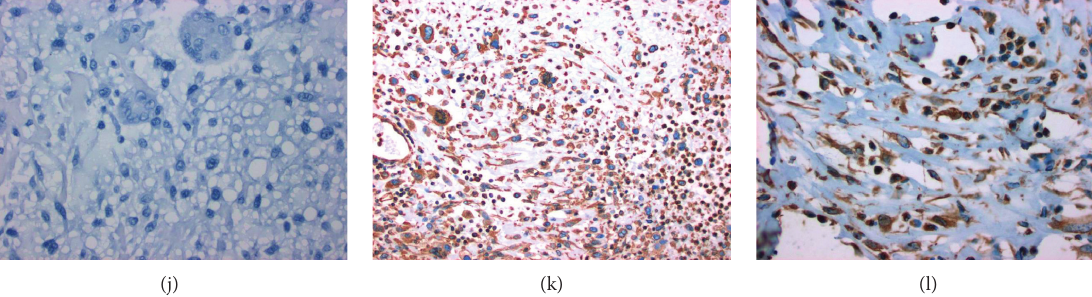
Figure 3: Microscopic pathology of the tumor. (a–d) Microscopic images of a fungating polyp. (a) Sheets of squamous cells displayed malignant features including large cell size and keratinization, providing evidence of squamous-cell carcinoma at 10x magnification. (b) The tumor arose in the background of a fundic gland polyp at 4x magnification. (c) Regions of the tumor and the entire lymph node metastasis displayed osteosarcomatous differentiation, evidenced by osteoid (pink) and associated atypical enlarged spindled cells at 20x magnification. (d) Evidence of both adenocarcinoma (left) and osteosarcoma (right) in the same fungating polyp tissue at 10x magnification. (e, f) AE1/AE3 staining. (e) Sarcomatous tissue of the tumor stained negative for AE1/AE3 seen at 20x magnification. (f) Adenocarcinoma component of the main tumor stained positive for AE1/AE3 imaged at 10x magnification. (g) Osteosarcoma component of the main tumor stained negative for AE1/AE3 at 10x magnification. (h) The squamous-cell carcinoma component was positive for P40 seen at 10x magnification. (i) The undifferentiated pleomorphic sarcoma was focally CD138 positive imaged at 20x magnification. (j) Beta-hCG was negative in giant cells, ruling out a choriocarcinoma component, seen at 20x magnification. (k) The undifferentiated pleomorphic sarcoma with osteoclast- like giant cells component was diffusely vimentin positive, seen at 10x magnification. (l) The osteosarcoma component of tumor was vimentin positive, imaged at 10x magnification.